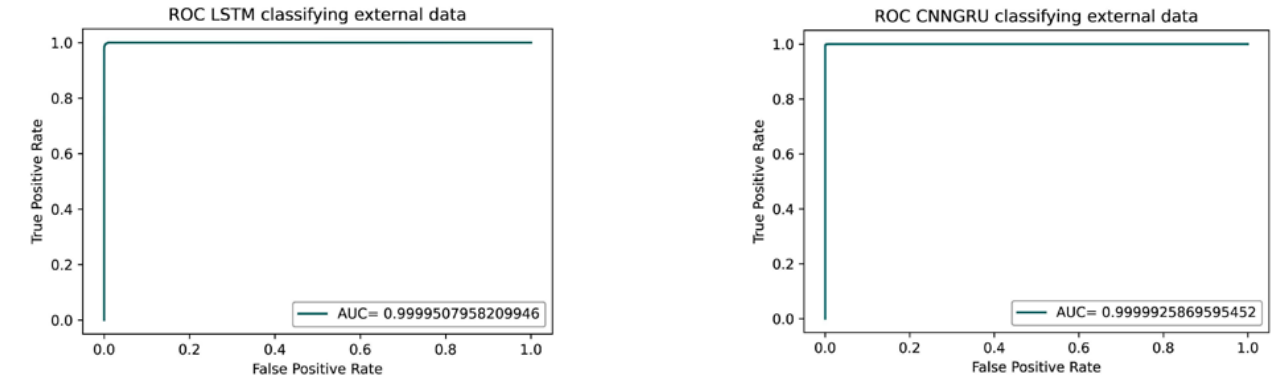
Figure 9. ROC and AUC curves while classifying external data from a public database. Left : LSTM model. Right : CNNGRU. Table 2. Comparative performance of LSTM and CNNGRU